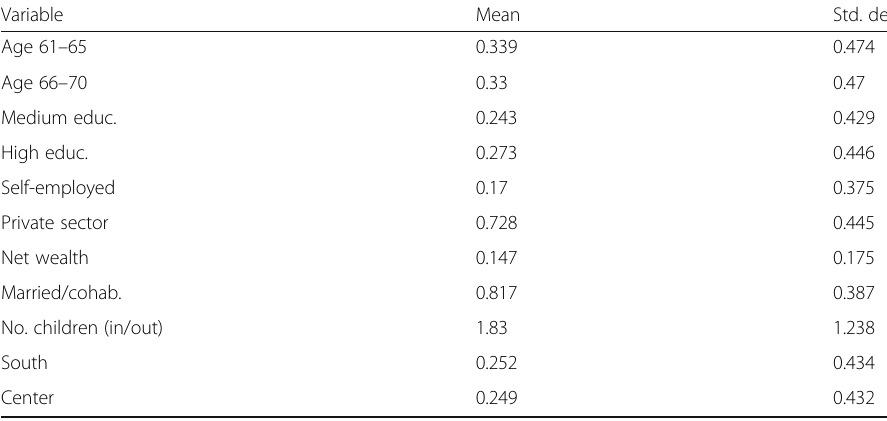
Table 2 Summary